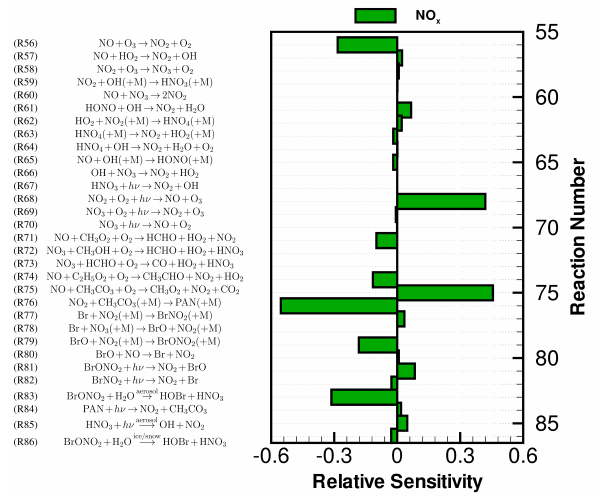
Fig. 11. Instantaneous relative sensitivities of NO x concentrations at day 4 for a boundary layer height of